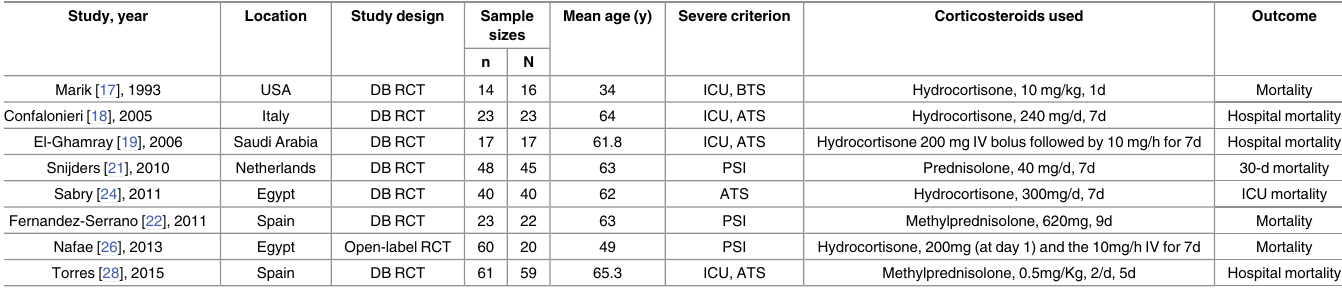
Table 1. Characteristics of included randomized controlled trials in the meta-analysis.